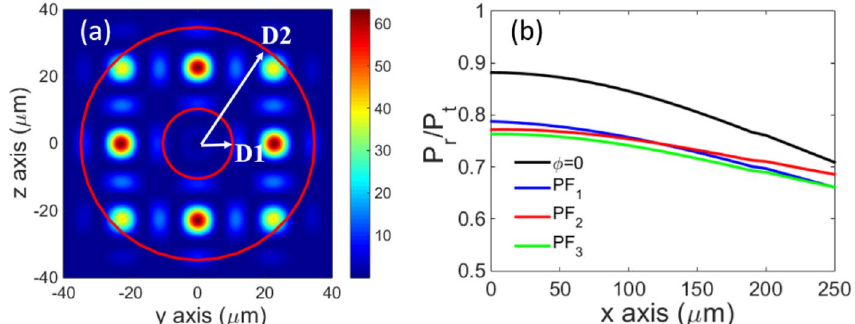
Figure 4. ( a ) Schematic of the ring used for the power-ratio calculation, where D 1 and D 2 represent the inner and outer ring radii, respectively. ( b ) The evolution of the ratio of the power in the ring p r to the total combined field power p t with the propagation distance in the cases of different random phases. PF 1 (phase fluctuation), PF 2 , PF 3 represent three random phase fluctuation